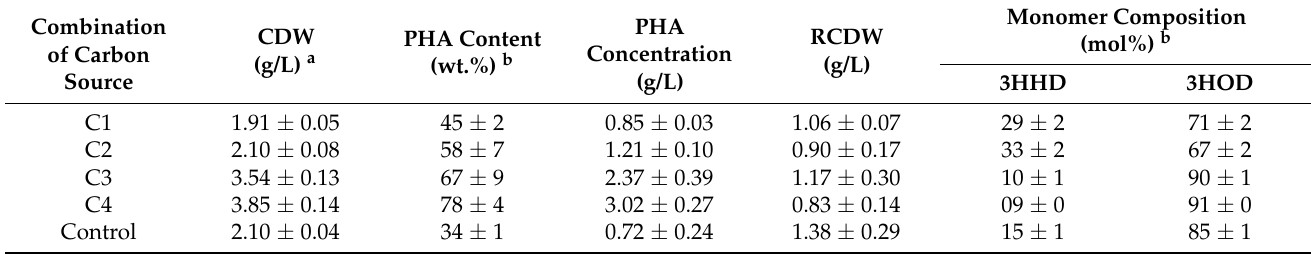
Table 5. Effect of additional/Co-carbon substrates on the growth and PHA biosynthesis by Acineto- bacter sp. strain AAAID-1.5.